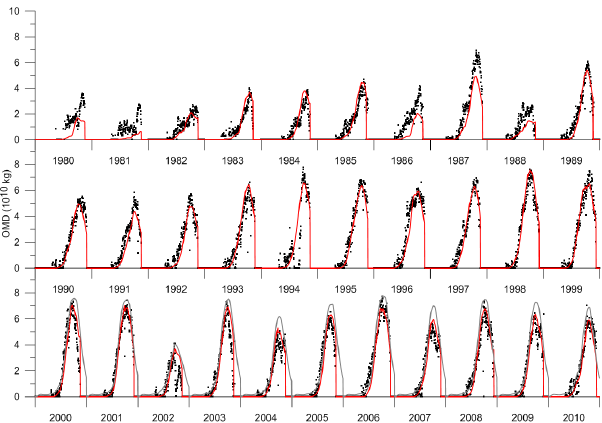
Fig. 4. OMD observations (black dots), OMD model (red line: full model, Eq. (2); grey line: simplified model). Note that the model is fitted to the OMD measurements from 1990 to 2000 and is forced to zero at the end of each season. The simplified model projections are only shown for 2000 to